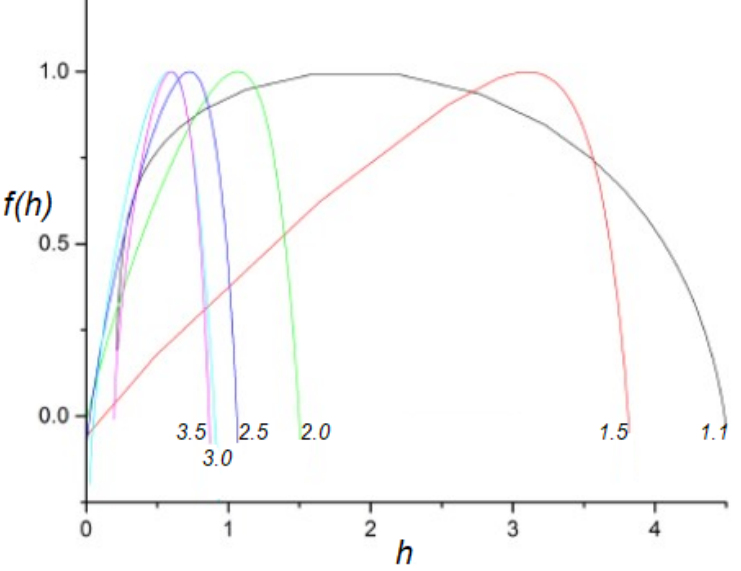
Figure 1. The multifractal spectra f ( h ) are plotted for the indicated values of the IPL index Figure 1: The multifractal spectrum f ( h ) is plotted for the indicated values of µ = 1.1,1.5, 2.0, 2.5, 3.0, and 3.5 without truncation. When µ is close to 1, the spectrum is the IPL index (cid:22) = 1 : 1 ; 1 : 5 ; 2 : 0 ; 2 : 5 ; 3 : 0 ; and 3 : 5 without truncation. When (cid:22) is very broad. As µ is increased, the spectrum narrows and its peak moves to h = 0.5. From [96] close to 1, the spectrum is very broad. As (cid:22) is increased, the spectrum narrows with and its peak moves to h = 0 : 5 . From [94] with permission.